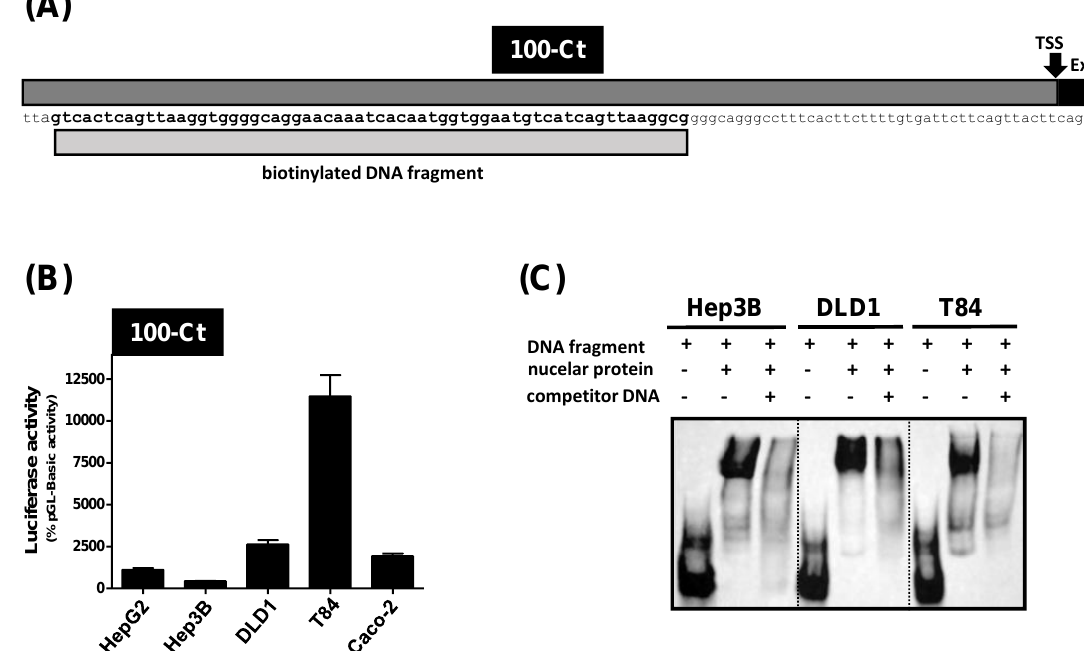
Figure 3. ( A ) Scheme of the 100-Ct reporter gene fragment. The light grey bar indicates the biotinylated DNA fragment which served as DNA probe for the EMSA shown in ( C ). ( B ) Comparison of the 100-Ct luciferase activities in the five tested cell lines (n = 4). ( C ) EMSA using the nuclear protein fraction of Hep3B, DLD1 and T84 cells and the biotinylated DNA fragment. The identical unbiotinylated fragment served as competitor DNA. TSS = transcriptional start site; Exon 1* = the alternatively spliced first exon of Ct-SLCO1B3.